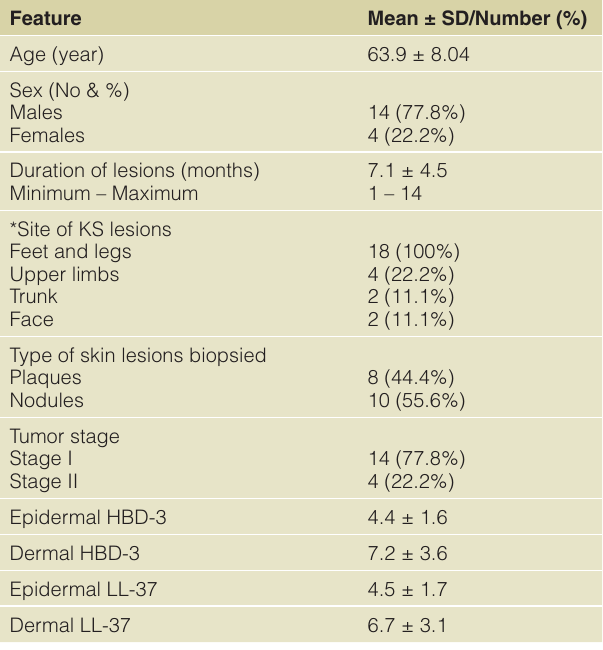
Table 1. Demographic, clinical features of studied patients and mean scores of immunostain of HBD-3 and